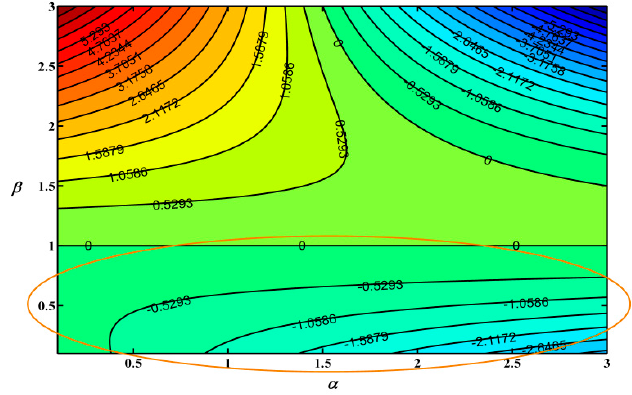
Figure 10. Contour plot of Equation (33).